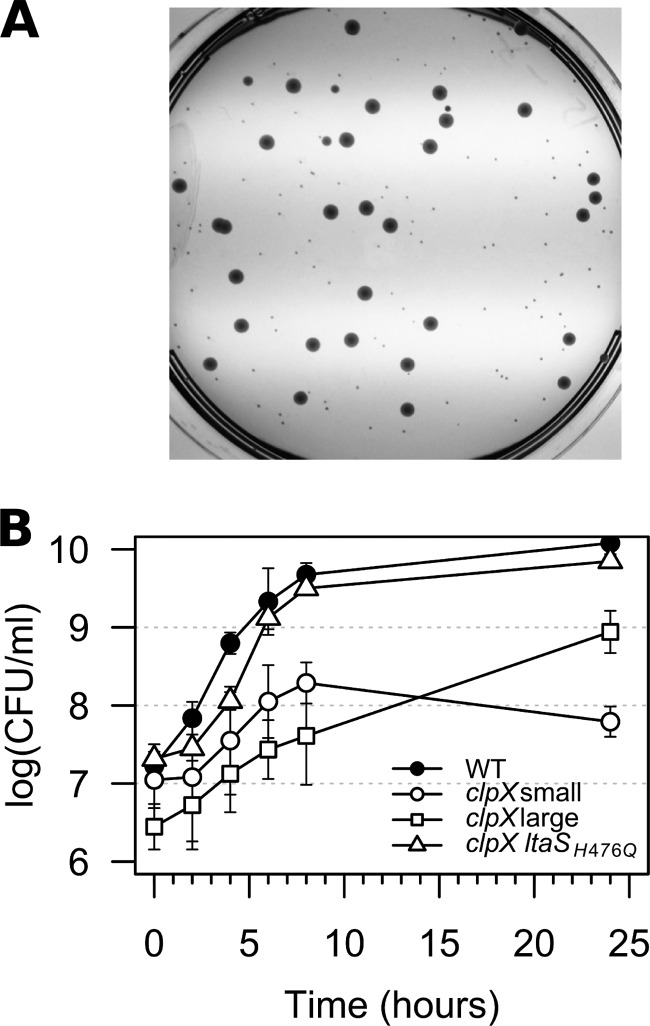
Spontaneous suppressor mutants restore growth of the S. aureus clpX mutant. (A) Faster-growing suppressor mutants appeared spontaneously in clpX cultures grown at low temperature. An overnight culture of the S. aureus SA564 clpX mutant was grown at 30°C in TSB, diluted and spread on a TSA plate, and incubated at 30°C for 48 h. (B) Growth of the S. aureus SA564 wild-type strain, the SA564 clpX strain, and the 564-25-2 (ltaSH476Q) spontaneous suppressor strain at 30°C in TSB measured as CFU per milliliter. Colony formation was assessed by incubating plates for 48 h at 30°C. “clpX small” indicates the count of small, normal-sized colonies, and “clpX large” indicates the count of large suppressor colonies. Values represent means of the results from three replicates, and error bars indicate standard deviations.